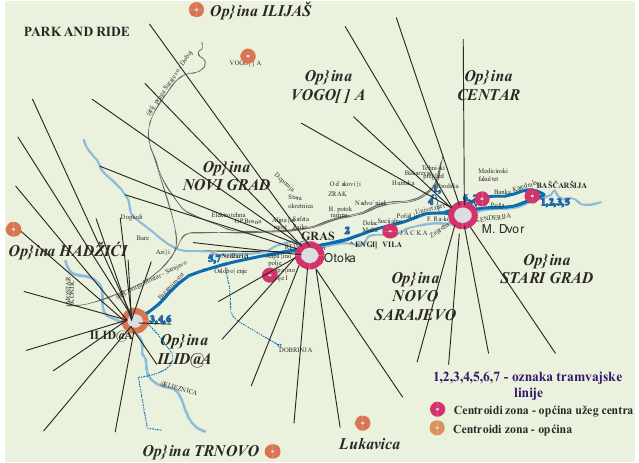
Figure 5. P&R system location plan in